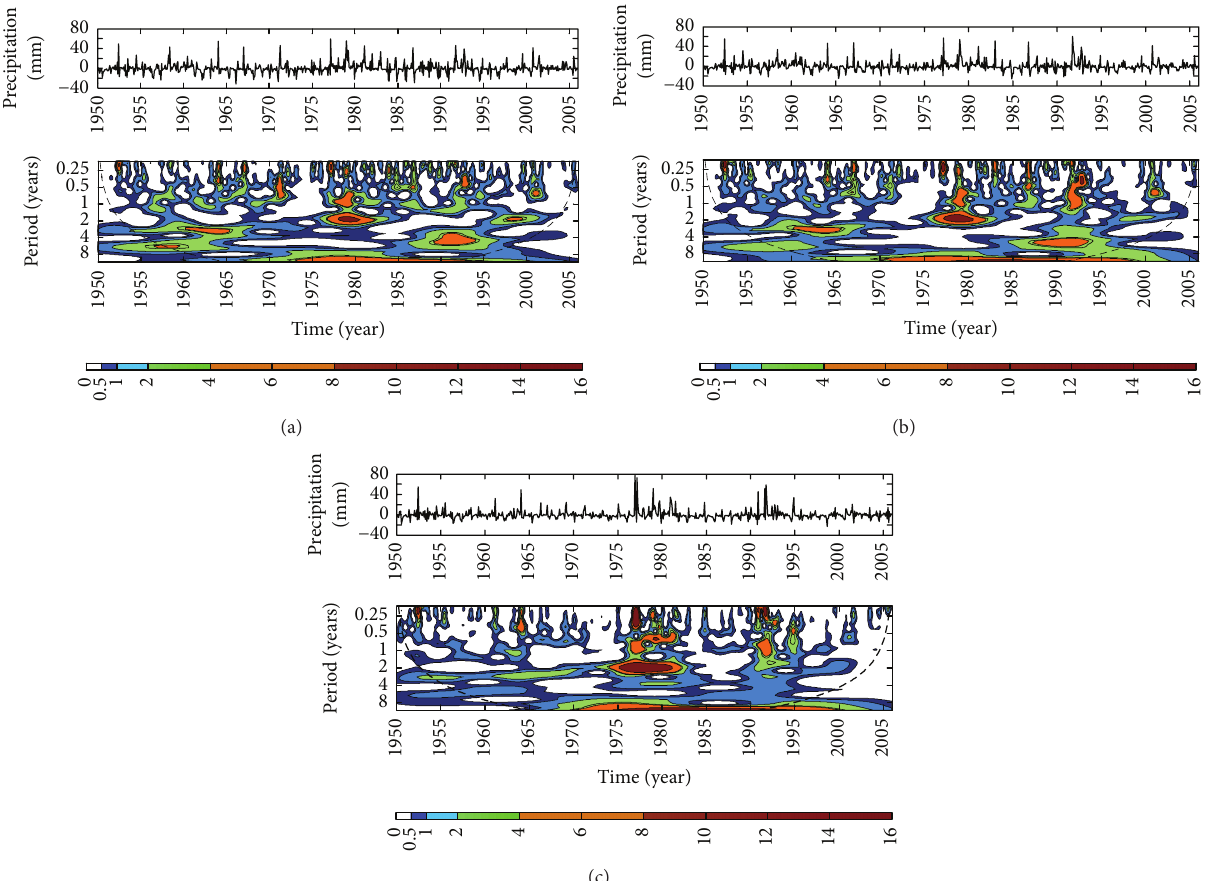
Figure 5: (a) The monthly precipitation anomaly time series in the upper stream of the Heihe River (upper panel) and its local wavelet power spectrum (lower panel) using the Morlet wavelet, normalized by 1/ 𝜎 2 ( 𝜎 2 = 126.45 mm 2 ). The dashed curve depicts the cone of influence beyond which the edge effects become important. The shaded contours are at normalized variances of 0.5, 1, 2, 4, and 8. The contour closes regions of greater than 95% confidence for a red-noise process with a lag-1 coefficient 𝛼 of 0.10. (b) Same as (a), but for the middle reach, with 𝜎 2 = 110.09mm 2 and 𝛼 = 0.09. (c) Same as (a), but for the lower reach, with 𝜎 2 = 95.96 mm 2 and 𝛼 =